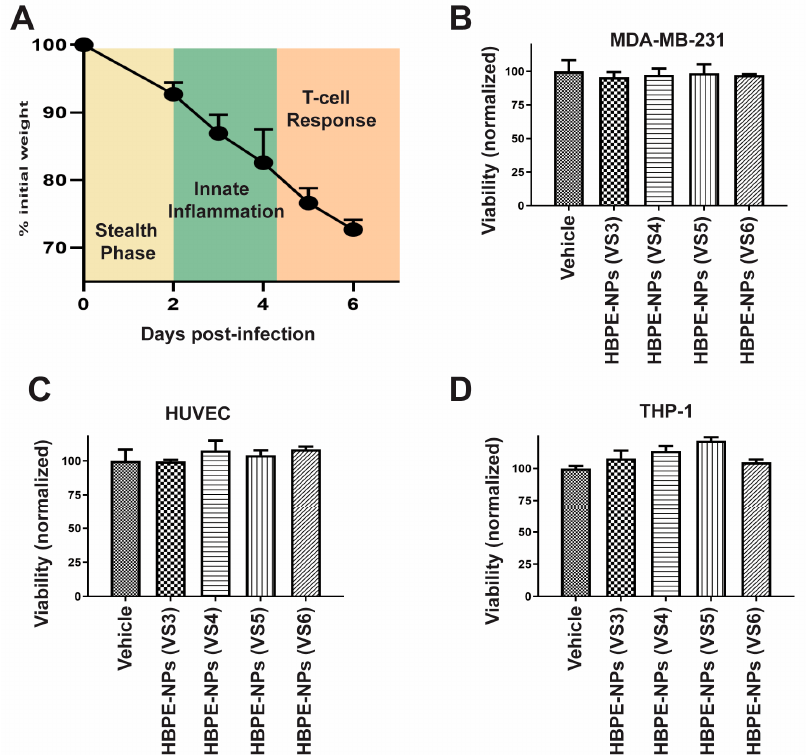
Figure 1. HBPE-NPs pre-treated with sera collected from IAV-infected mice are non-toxic. ( A ) Scheme showing the process of IAV infection in C57BL/6 mice, correlating the phase of the immune response with weight loss. ( B – D ) MTT viability assay was performed to assess the toxicity of sera-coated NPs. MDA-MB-231 cells ( B ), HUVECs ( C ), and THP-1 cells ( D ) were treated with vehicle (water), HBPE-NPs pre-coated with sera collected from day 3 post-IAV infection [HBPE-NPs (VS3)], day 4 post-IAV infection [HBPE-NPs (VS4)], day 5 post-IAV infection [HBPE-NPs (VS5)], or day 6 post-IAV infection [HBPE-NPs (VS6)]. Data represent mean ± standard deviation (n = 3). To detect the absorption of proteins from VS3-6 by particles, the diameter of the HBPE-NPs was analyzed, after incubation with sera, by dynamic light scattering (DLS) using a modified protocol from Zheng et al. [30]. Briefly, when HBPE-NPs bind sera proteins, such as immunoglobulin G (IgG), anti-IgG-specific antibodies can be used to detect these absorbed proteins, which changes the diameter of the HBPE-NPs detected by DLS [30]. After treatment with VS3-6, HBPE-NPs decreased in average diameter (Table 1), an effect previously noted and likely due to sera proteins constricting the branching of the HBPE polymer [19]. The addition of anti-IgG antibodies led to increases in the average diameter of HBPE-NPs (VS3), HBPE-NPs (VS4), HBPE-NPs (VS5), and HBPE-NPs (VS6) by ~21.9%, ~12.3%, ~6.3%, and ~11%, respectively, indicating that HBPE-NPs absorbed sera proteins (like immunoglobulins) produced by IAV-infected mice. While not conclusive, these